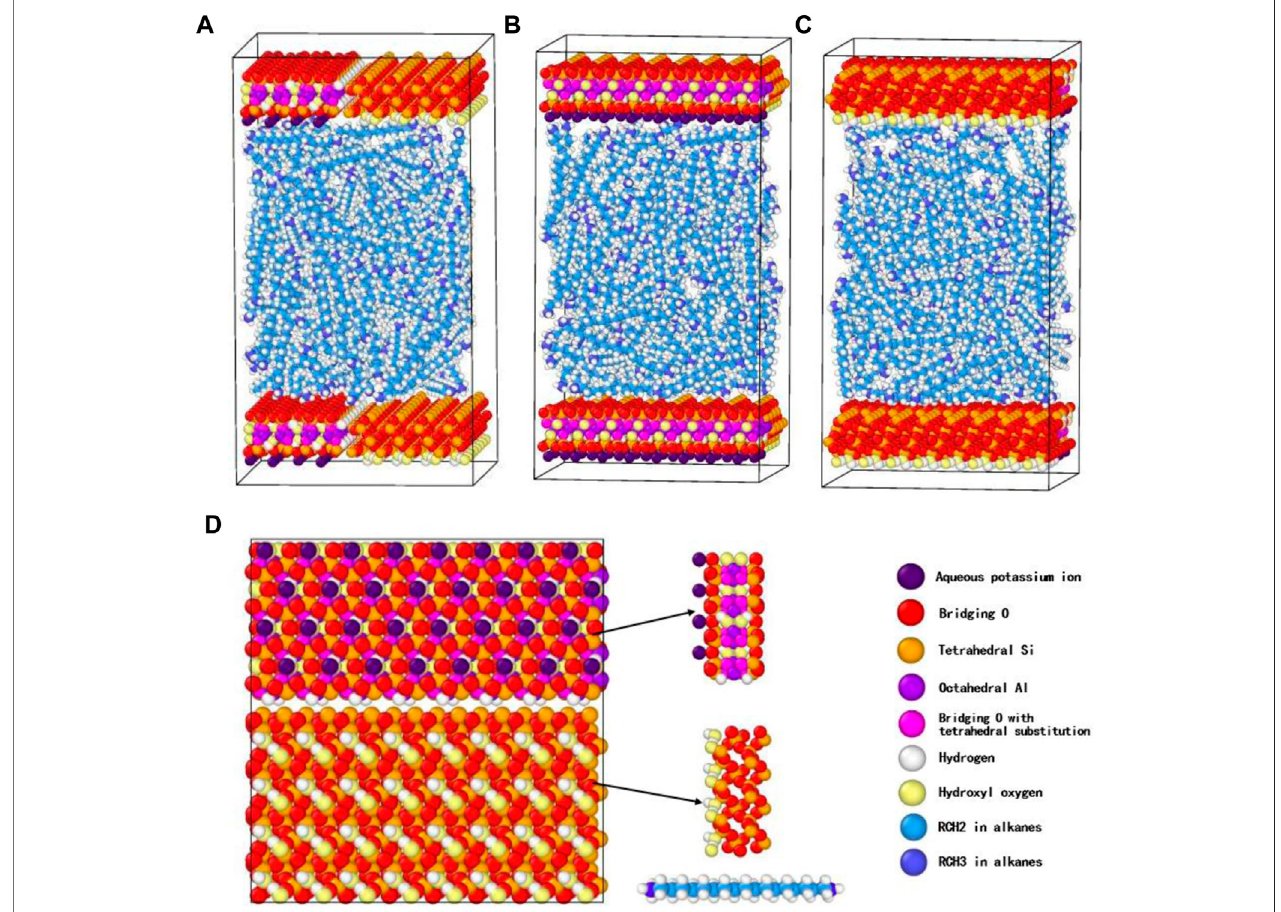
FIGURE 3 | Snapshot (front view) of the initial system for nC19 in a 5 nm pore. (A) Front view; (B) Left view-illite; (C) Right view-quartz; (D) Top view.